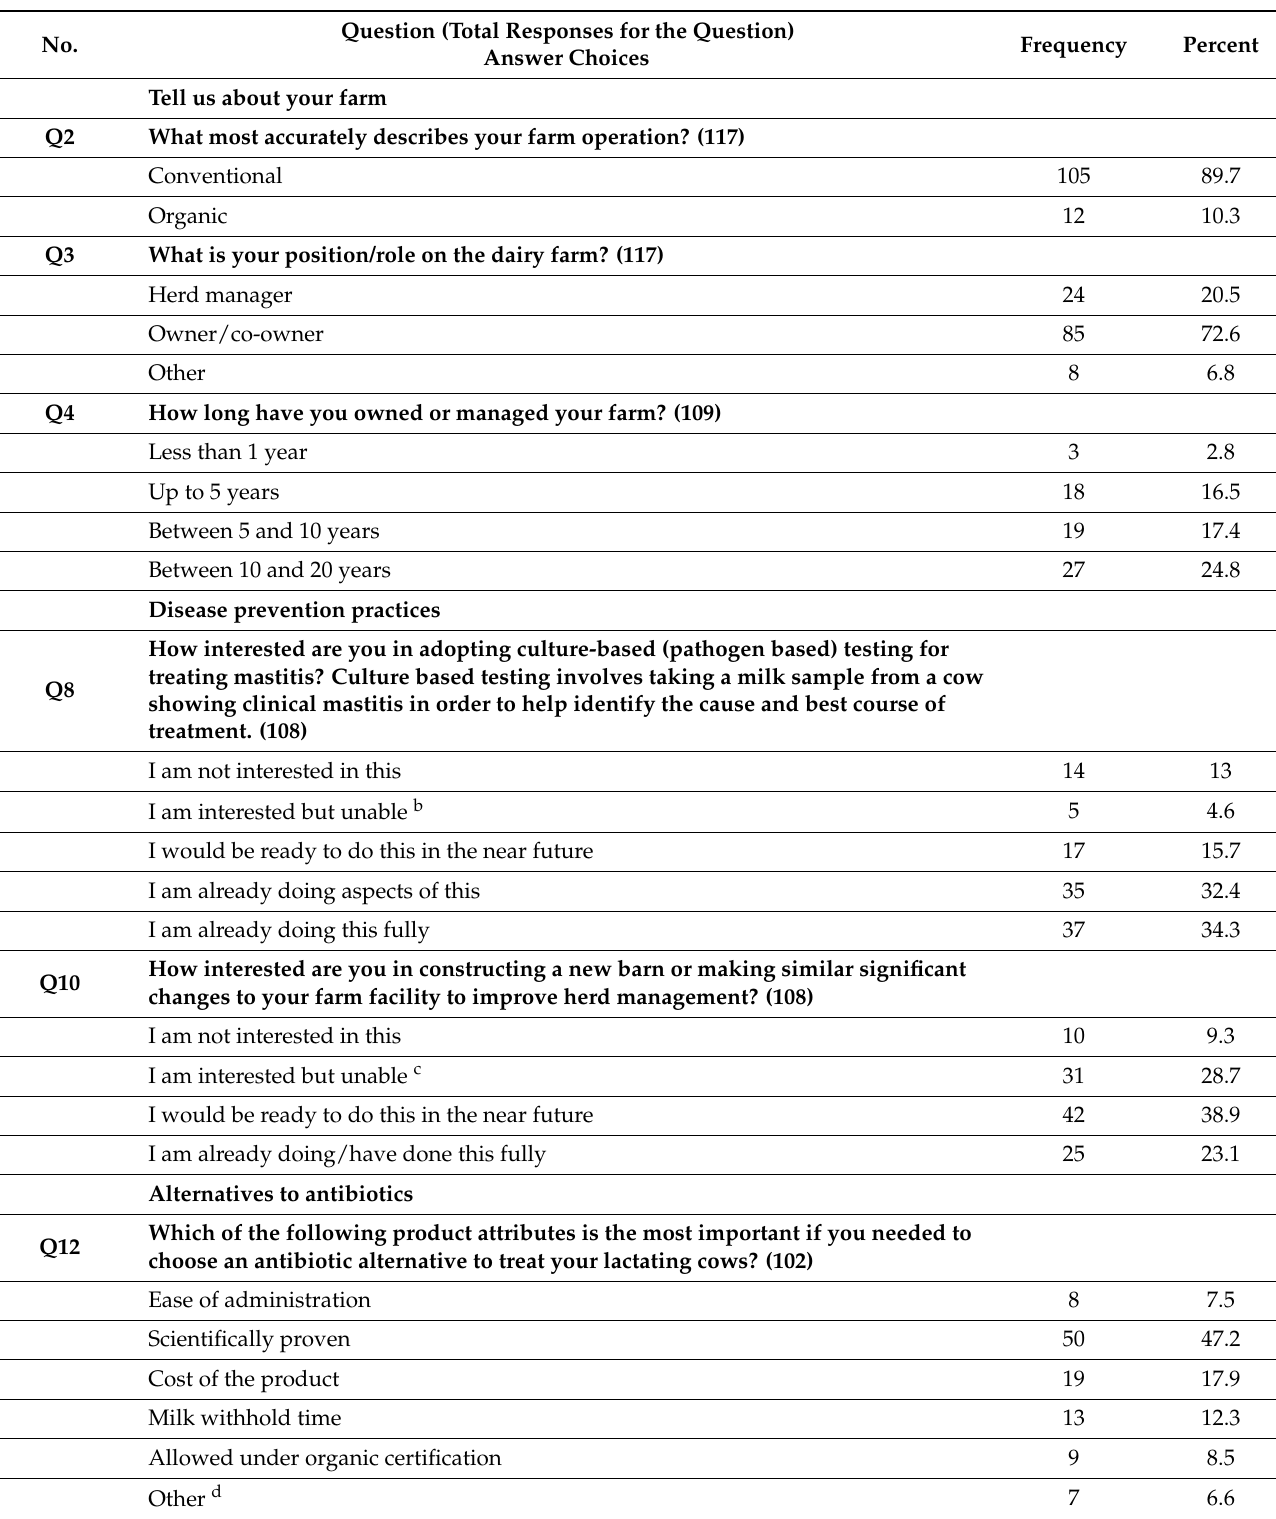
Table 1. Descriptive statistics for the responses to the categorical survey questions in the order they appeared in the survey instrument a